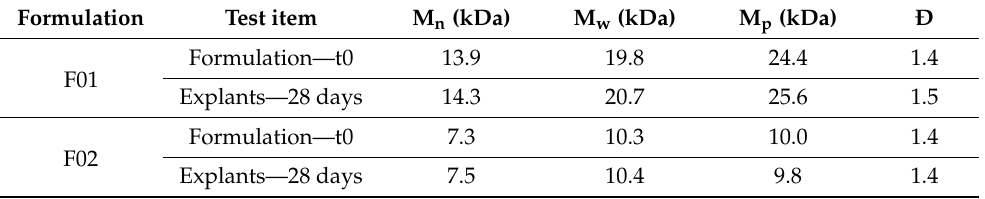
Table 4. GPC–RI values obtained from F01 and F02 formulations pre- and post-in vivo administration.